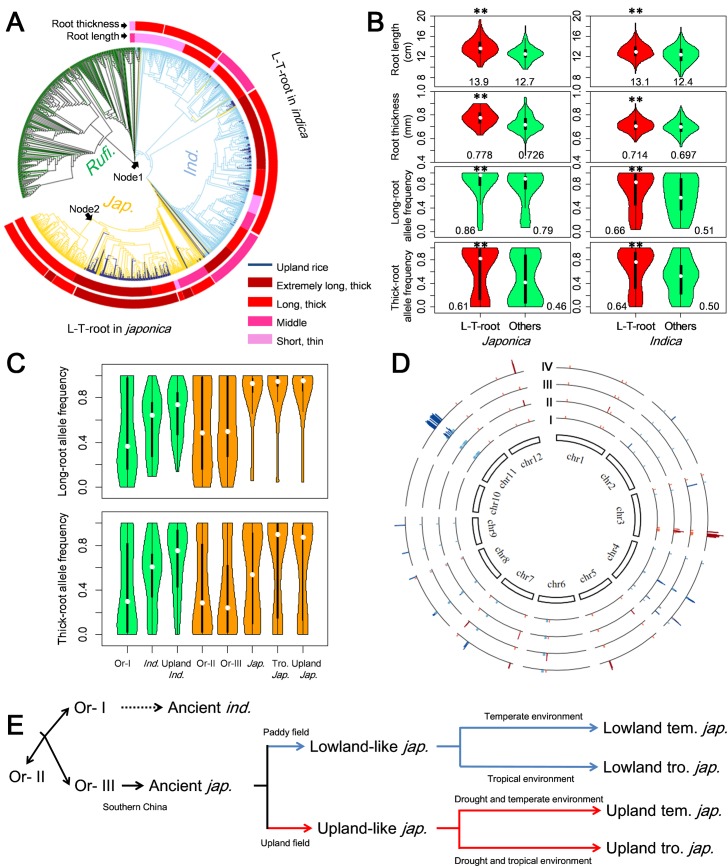
A hypothetical adaptive domestication history of upland rice accessions with robust roots.(A) The phylogenetic tree of the 446 O. rufipogon and 997 O. sativa accessions based on 5,779 SNPs within the candidate genes for robust roots. (B) Comparisons of robust-root phenotypes and allele frequencies between accessions in the long-thick-root (L-T-root) region and other varieties in the corresponding subpopulations; in which the X-axis indicates different groups, and the Y-axis indicates the mean root length and thickness values plotted in the top panel and the long-root and thick-root allele frequencies plotted in the bottom of panel. There are significant differences between red violin and green violin distributions in each plot, and the number represents average value of the adjacent violin. (C) Comparisons of frequencies of the long-root alleles and thick-root alleles at candidate genes in O. rufipogon and O. sativa subpopulations and ecotypes. Y-axes show allele frequencies for long-roots (upper) and thick-roots (lower), and X-axis represents different groups. Or-I is indica-like O. rufipogon accessions colored blue as indica, and Or-II and Or-III are intermediate and japonica-like O. rufipogon accessions colored yellow as japonica. (D) Ratios of genetic diversity among different groups. The log2-transformed ratios of πw/πJ, πw/πI, πnon-L-T-root/πL-T-root in indica and πnon-L-T-root/πL-T-root in japonica are plotted against the position on each chromosome, marked by Roman numeralsⅠ,Ⅱ, Ⅲ and Ⅳ. Red and blue represent root length and root thickness candidate genes and the bar lengths indicate log2-transformed ratios. Details are listed in S17 Table. (E) Adaptive domestication schematics of upland rice in aerobic conditions. Black lines and dotted line show known and unclear domestication history. Blue and red lines indicate adaptive domestication history of lowland and upland japonica ecotypes in tropical and subtropical environments and temperate environment, respectively.